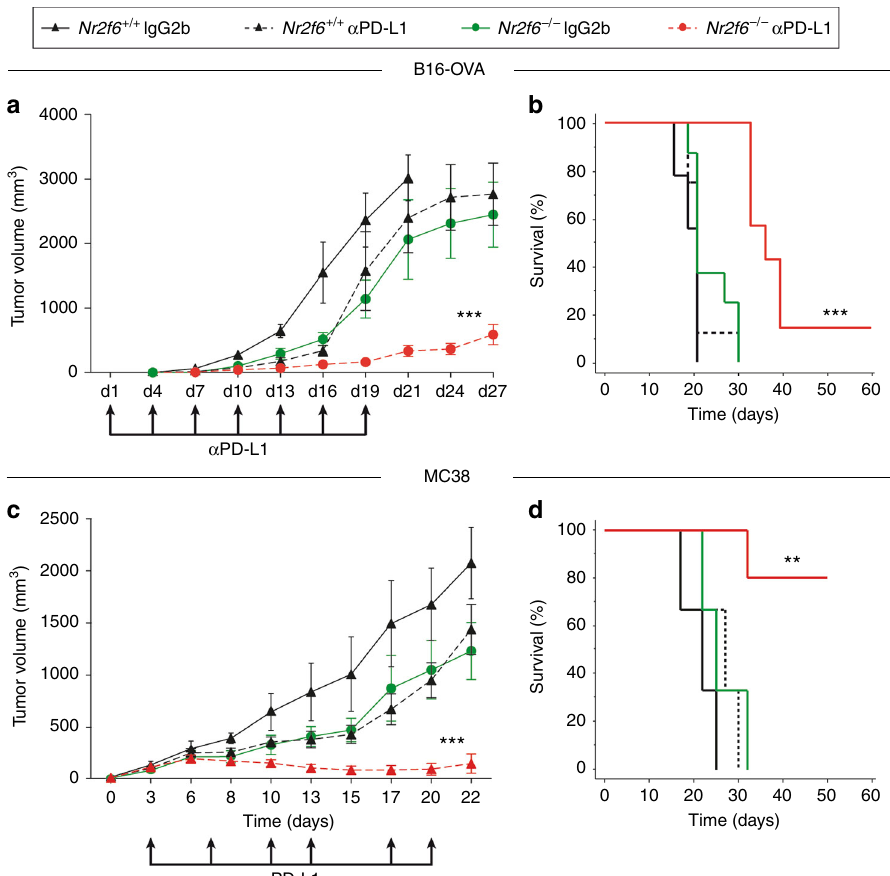
Fig. 2 Gene ablation of NR2F6 acts as “ sensitizer ” for the established immune checkpoint blockade in mouse tumor models in vivo. a Tumor growth curve ( p <0.0001, ANOVA, n = 9) and b Kaplan − Meier survival curve ( p <0.0001, log-rank test, n = 9) of Nr2f6 + / + and Nr2f6 − / − mice that received the high dose of 5×10 5 B16-OVA tumor cells subcutaneously and were treated either with “ mono-therapies ” of genetic Nr2f6 inhibition (green, IgG2b) or PD-L1 blockade in wild-type mice (dashed black, employing the established Ab10F.9G2) or treated with a “ combination therapy ” (red) ( n = 8). c Tumor growth ( p < 0.0001, ANOVA) and d Kaplan − Meier survival curves ( p = 0.0031, log-rank test) of Nr2f6 + / + and Nr2f6 − / − mice that received the high dose of 7.5×10 5 MC38 tumor cells subcutaneously and were treated either with “ mono-therapies ” of genetic Nr2f6 inhibition (green, IgG2b isotype control, n = 7) or PD-L1 blockade in wild-type mice (dashed black, n = 10, the latter employing the established protocol with neutralizing Ab10F.9G2) or with a “ combination therapy ” (red, n = 12) (wild-type IgG2b control group, black, n = 5). Results shown are derived from at least two independent experiments. Error bars represent the mean ±